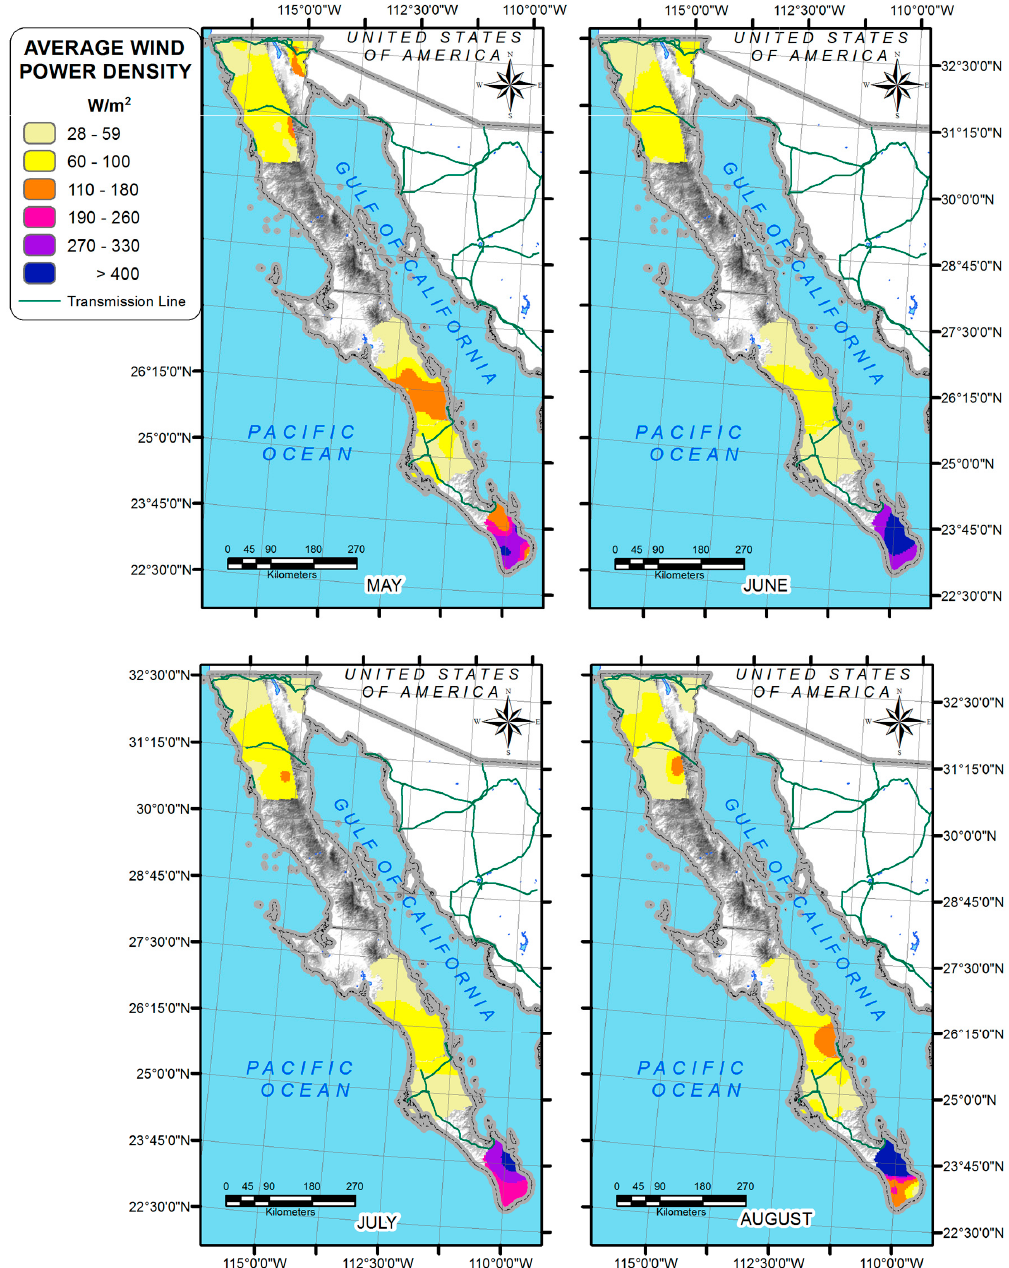
Figure 13. Average WPD from May to August.